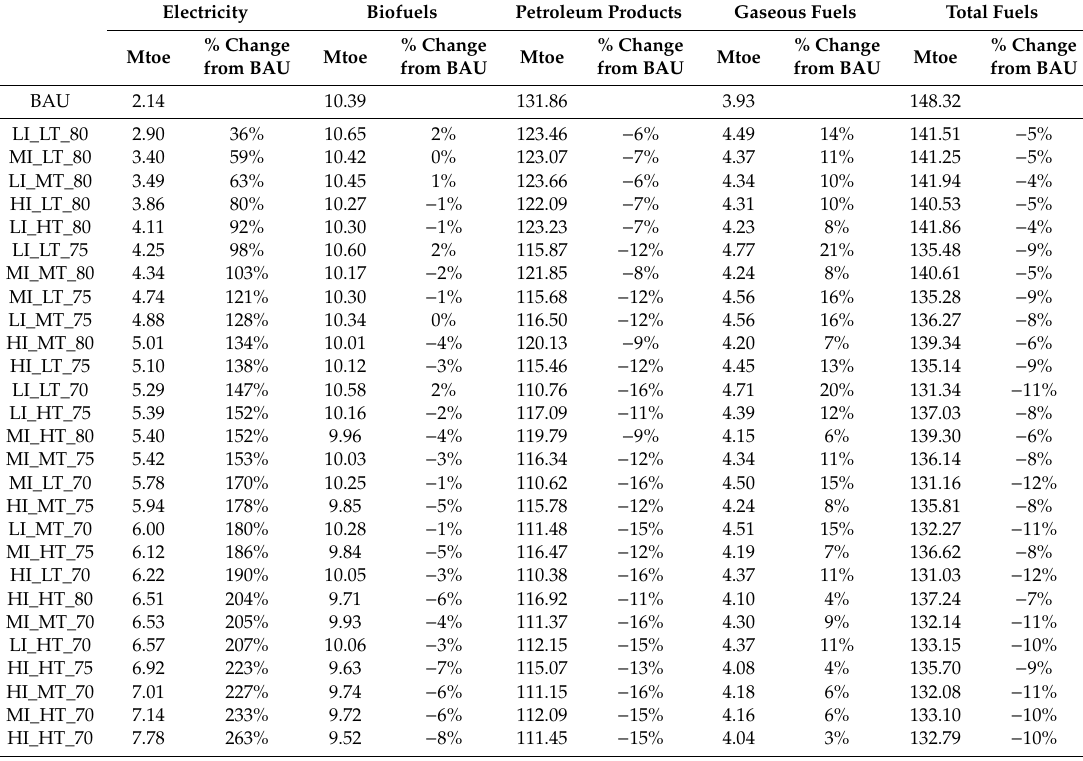
Table 6. Energy consumption of private cars in 2030 in the EU (di ff erence and % change from BAU). Electricity Biofuels Petroleum Products Gaseous